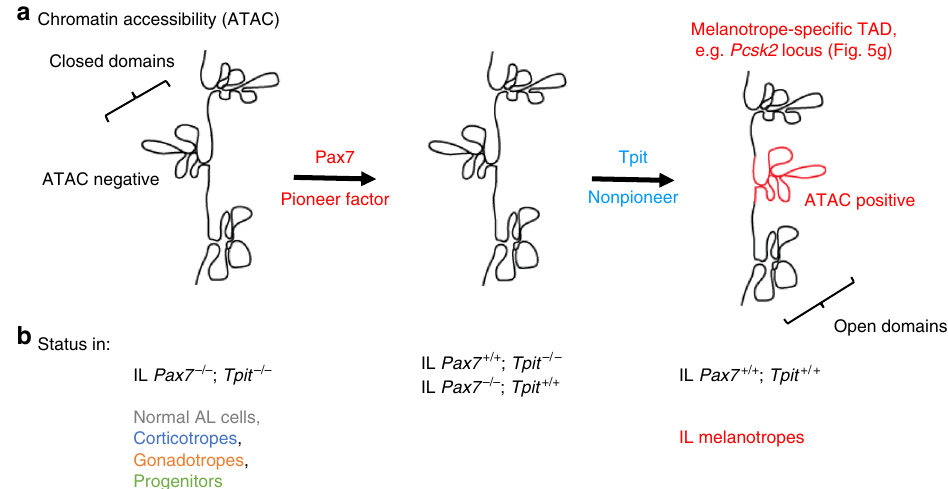
Fig. 7 Pioneer action of Pax7. Cooperative chromatin opening by the pioneer Pax7 and the nonpioneer factor Tpit. The heterochromatin target sites of pituitary Pax7 pioneer action typically contain Pax7 DNA binding sites together with Tpit binding sites within a few hundred bp of each other. a , b Schematic representation of chromatin accessibility ( a ) assessed by assay for transposase-accessible chromatin using sequencing (ATACseq) at a pituitary melanotrope-speci fi c TAD containing the Pcsk2 gene (red domain). This domain presents multiple ATACseq peaks in wild-type melanotrope of the pituitary intermediate lobe (IL). This chromatin accessibility is not observed in cells of other pituitary lineages or in mutant ILs of single or double mutants for Pax7 and/or Tpit ( b ). Similar observations were made for the Pcsk2 (Fig. 5g), Drd2 and Grik1 loci (Supplementary Fig.